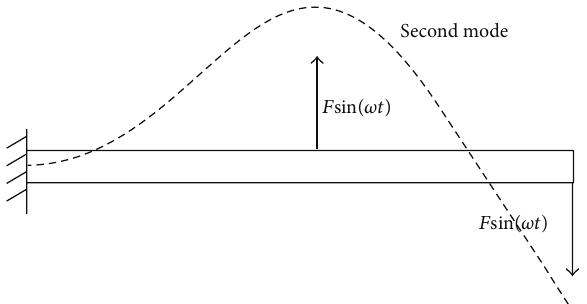
Figure 3: Clamped beam with two external forces together with the second mode. Even if the excitation frequency is lower than the 1st natural frequency of the system, depending on the force locations, othermodesmightplayaroleinthedynamics.Fortheconfiguration in the figure, the second mode will be important.